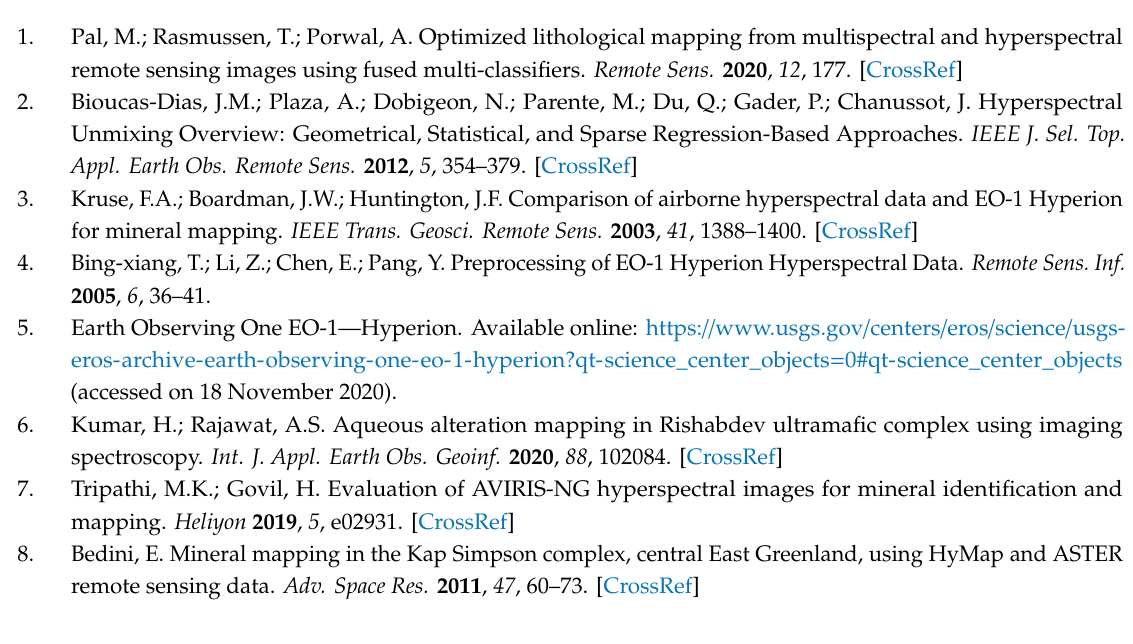
Table S1: Parameters of convolutional layers in M3D-DCNN method. Table S2: Other parameters of M3D-DCNN method. Table S3: Parameters of layers in HybridSN method. Table S4: Other parameters of HybridSN method. Table S5: Parameters of LSTM layers in SSUN method. Table S6: Parameters of MSCNN layers in SSUN method. Table S7: Other parameters of SSUN method. Table S8: Parameters of SVM-RBF